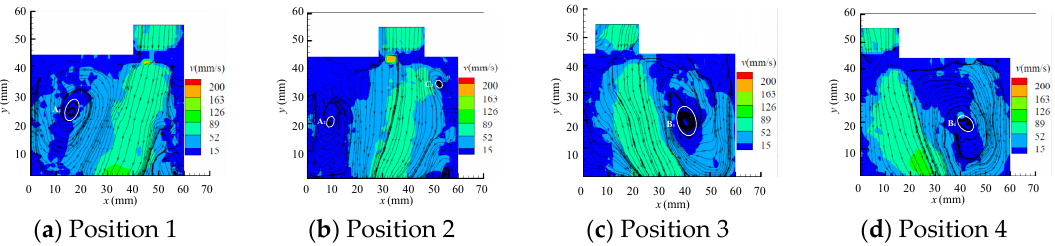
Figure 18. Velocity contours and streamlines with a piston moving speed of 8.3 mm/s.